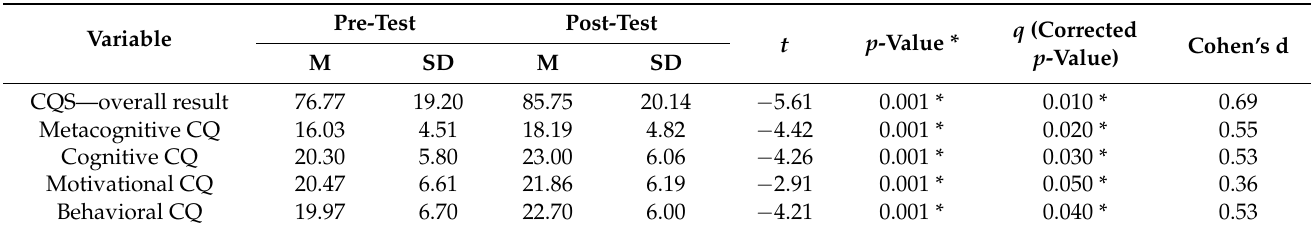
Table 1. Overall results of the Cultural Intelligence Scale (CQS) and subscales of nursing students in 2019 (study 1). Variable